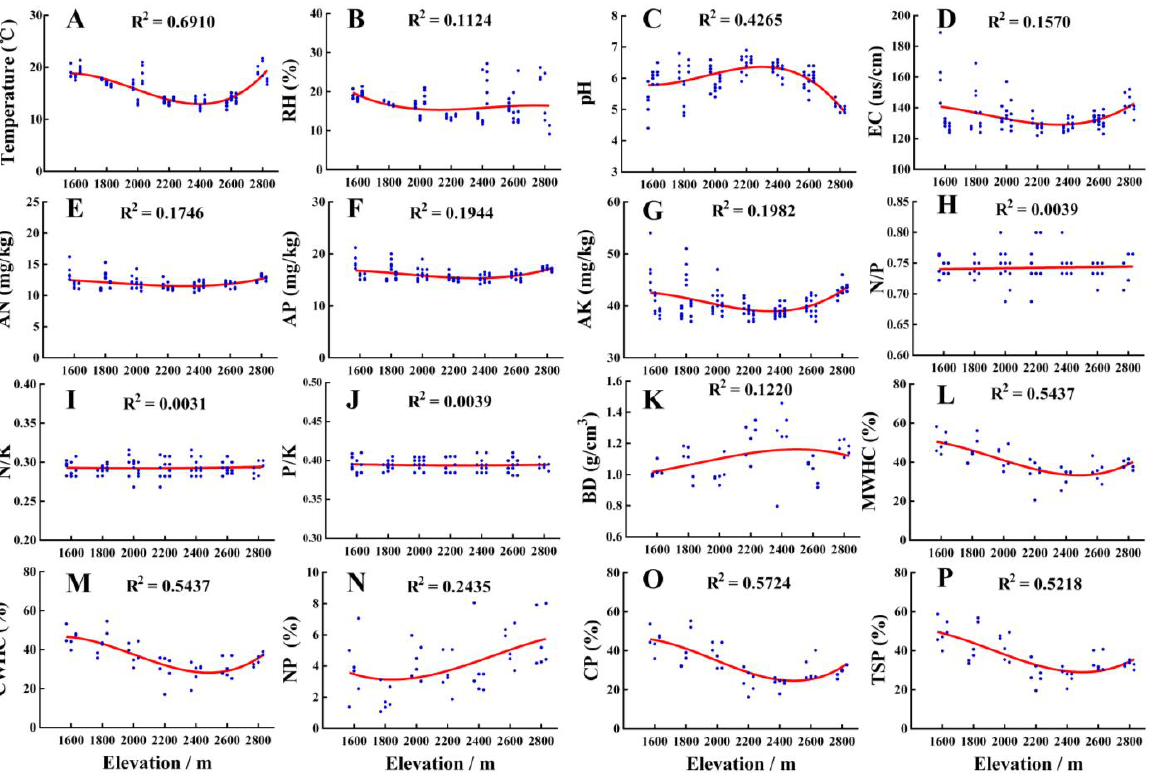
Figure 2. Variations of soil physicochemical properties along altitudinal gradient in the